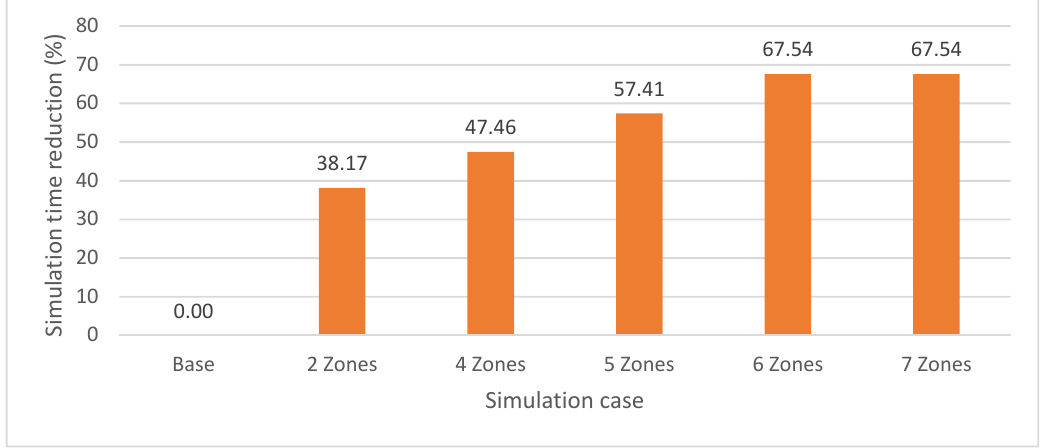
Figure 6. Simulation time reduction as a percentage of the reference.